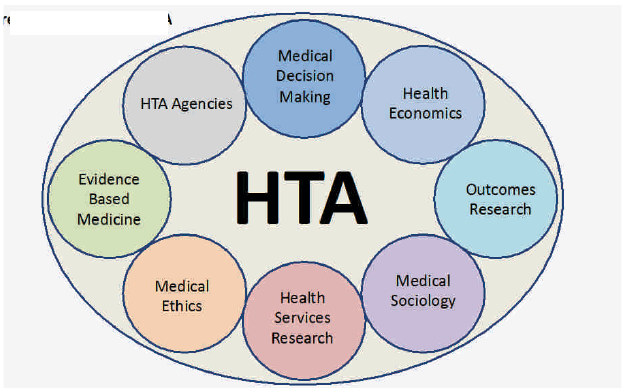
Figure 1: Components of